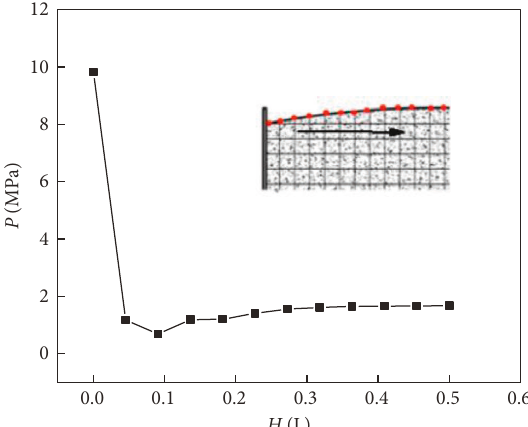
Figure 14: Change of P along member height when RCFSTreaches peak load after high temperature.